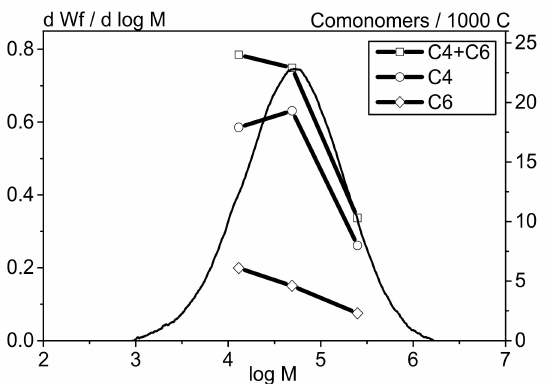
Figure 8. The curves showing molecular weight distribution (1), total content of the comonomers (2), content of the comonomer (1-butene) (3), and content of the comonomer (1-hexene) (4) in all the LLDPE-2